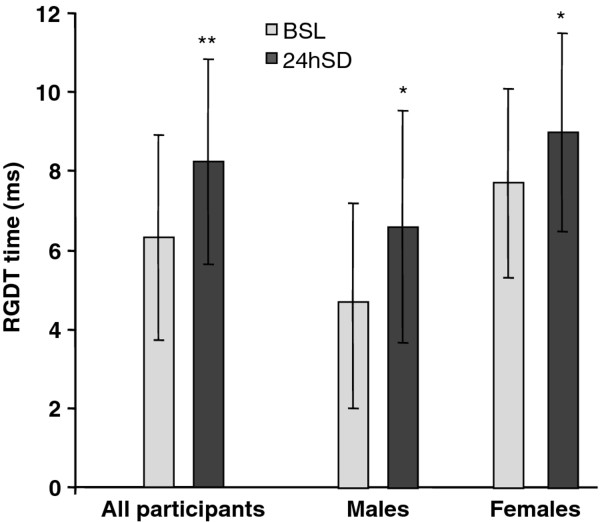
RGDT performance was impaired by sleep deprivation. Mean RGDT times following 24 hours of sleep deprivation (24hSD) were significantly greater than those observed during the baseline condition (BSL) without sleep deprivation. Error bars show standard deviations. *p ≤0.01, **p ≤0.001 vs. BSL for whole study cohort (left).